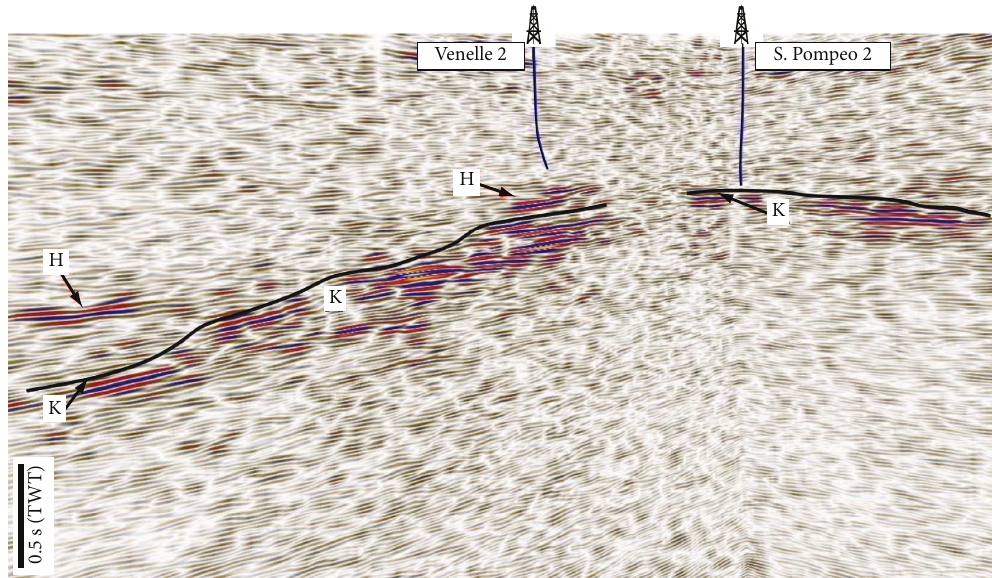
Figure 4: A re fl ection seismic section from the literature (modi fi ed after [16]). This fi gure shows the two deep seismic markers, the H-horizon and K-horizon. The K-horizon upper boundary is shown in